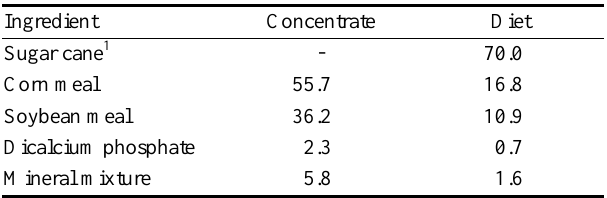
Table 1. The percentage composition of concentrate and diet ingredients (% of DM) Ingredient Concentrate